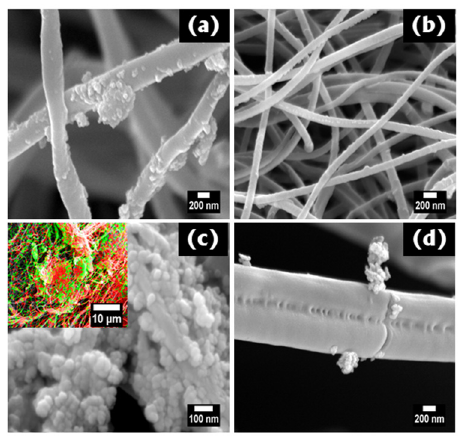
Figure 2. HR-SEM images of ( a ) PVA/ZnO, ( b ) PA6/ZnO, ( c ) PVDF/ZnO, and ( d ) PLLA/ZnO nanofibers. Inset image is the EDX mapping of PVDF/ZnO nanofiber. (green—Zn; red—C).